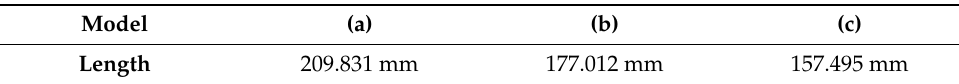
Table 7. Top expansion length of models.